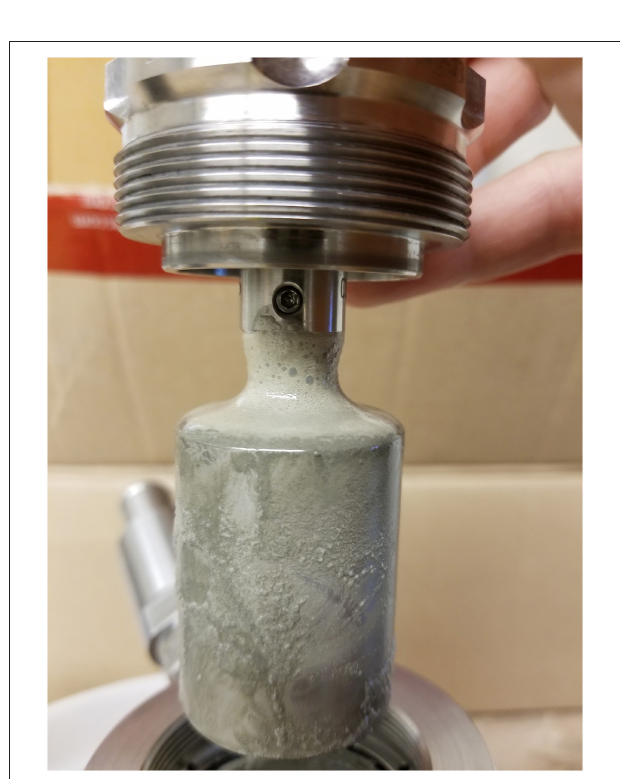
FIGURE 5 | The pressurization/depressurization of the samples yielded a substantial volume of foam on top of the inner cylinder of the pressure cell. Picture taken after removing the inner cylinder from the pressure